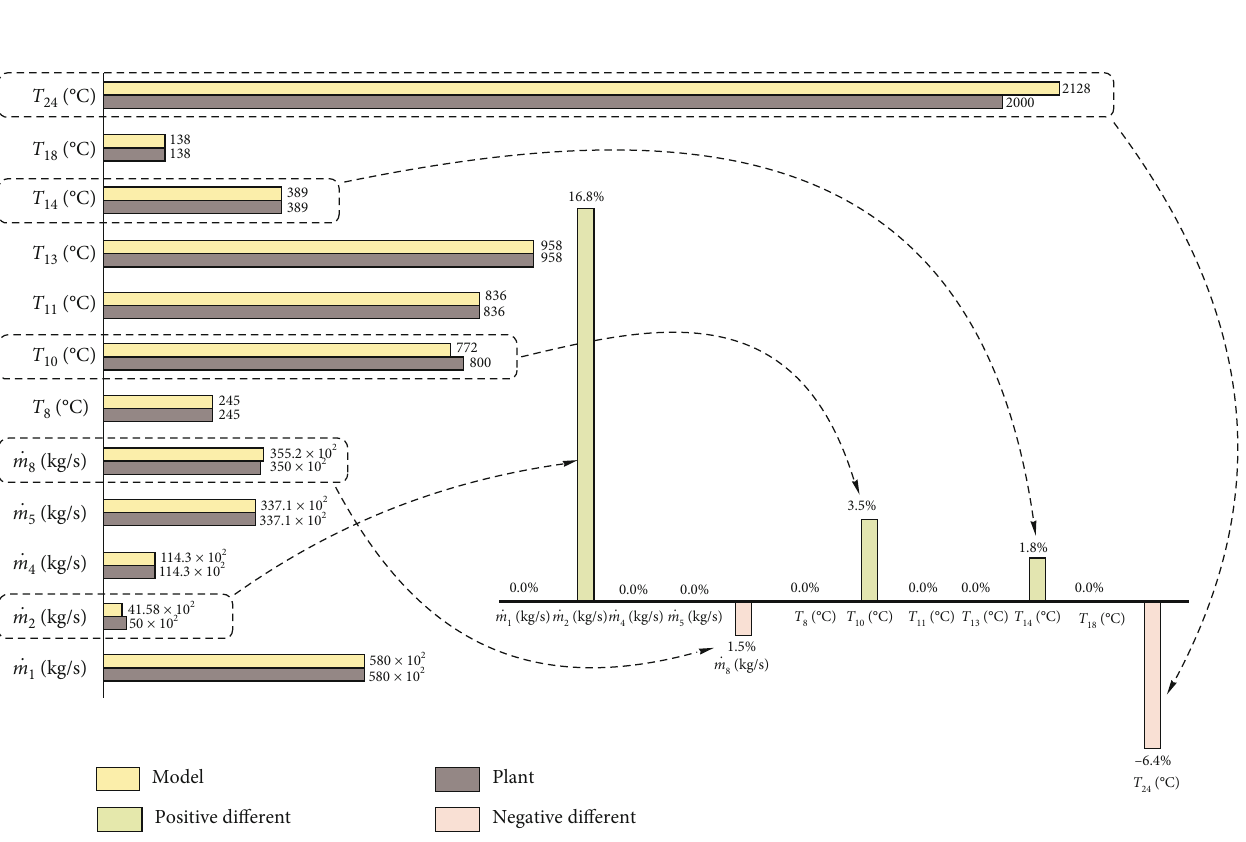
Table 2: Comparison of weight percent composition of clinker (in % wt) between the real plant data and simulation results. Substance SiO Real plant data Simulation results Substance TiO Real plant data Simulation results